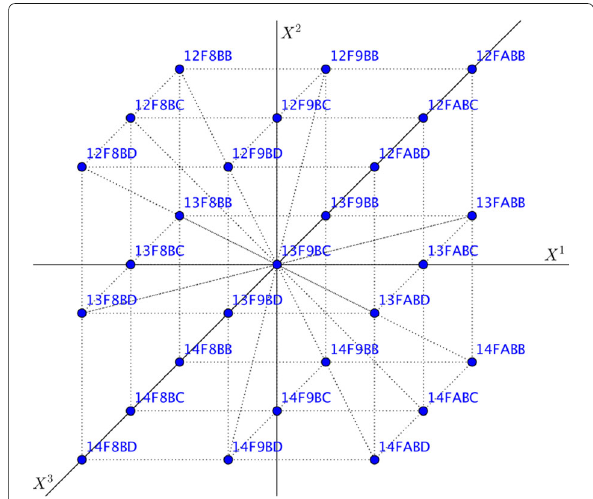
Fig. 3 Hexadecimal addressing in a 3-d SHAM system. Node 13F9BC has 26 direct neighbors organized in sequential order on each coordinate